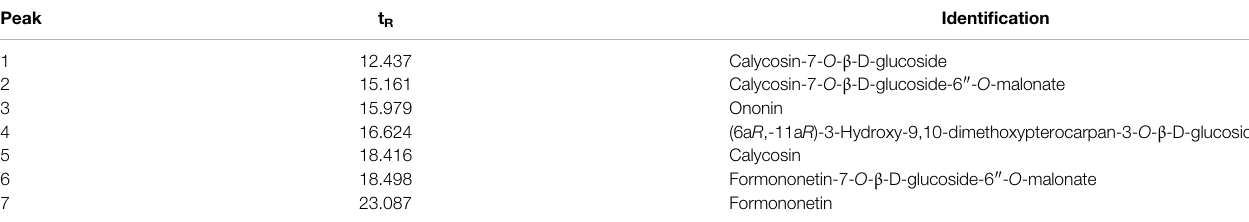
TABLE 1 | Chemical components identi fi ed from R . astragali by HPLC-ESI/MS n . Peak